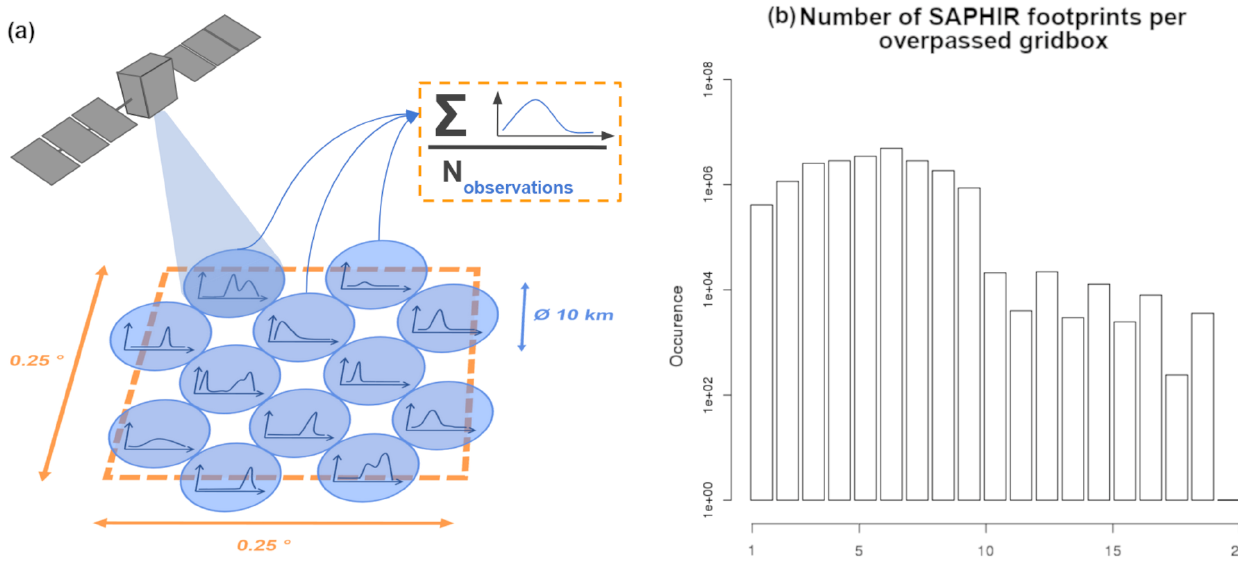
Figure 1. (a) Colocalization diagram of SAPHIR’s PDF FS and ARPEGE grid and (b) distribution of the sample size of SAPHIR footprints in ARPEGE grid boxes (log